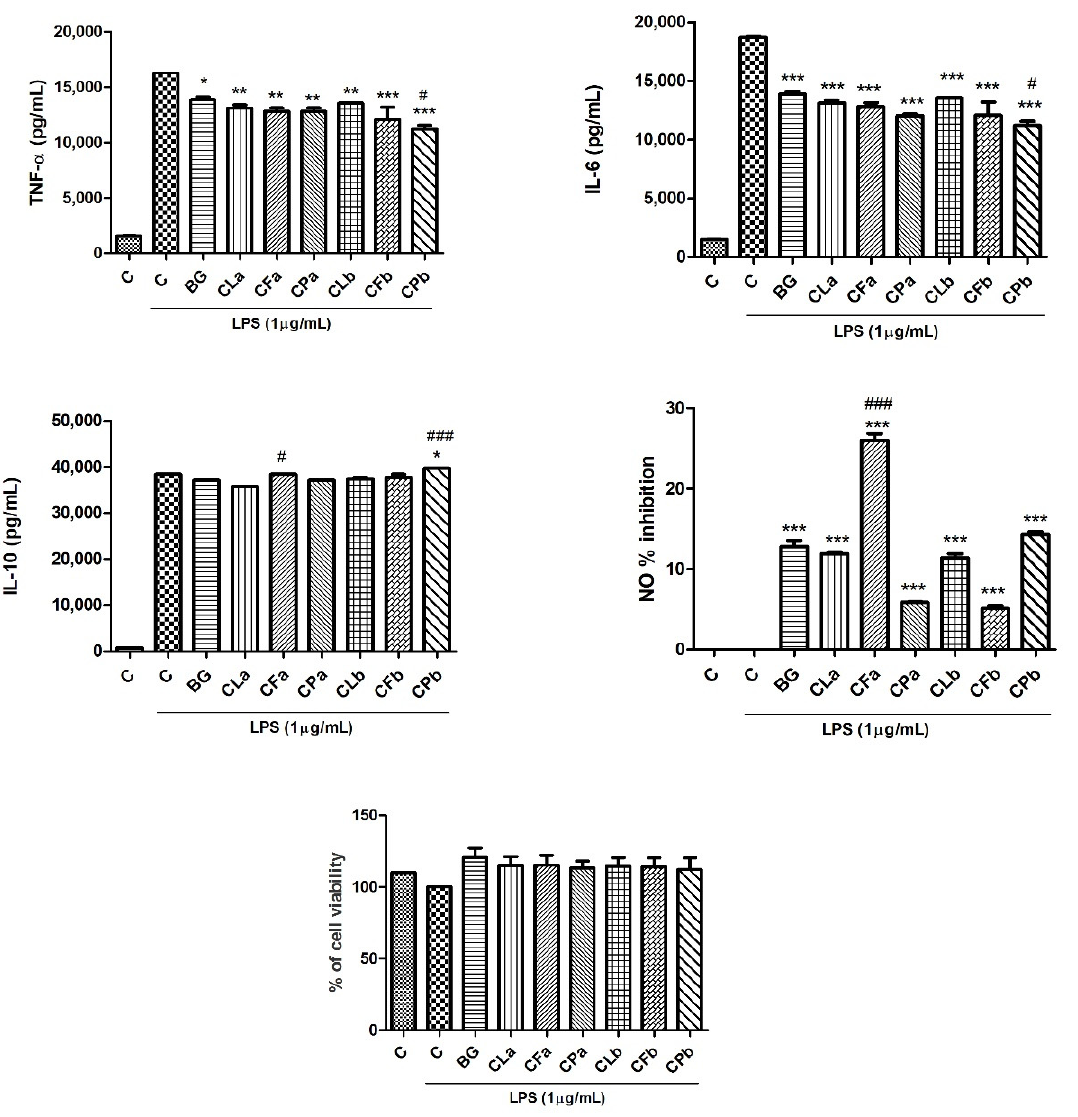
Figure 4. Bergapten (BG) was used as positive control. CL: C. libanotis ; CF: C. ferulacea ; CP: C. pungens . Formulations “a” and “b” were prepared as reported in the Materials and Methods Section 3.2. Significant difference versus control with LPS: * p < 0.05; ** p < 0.01; *** p < 0.001; significant difference versus bergapten (positive control): # p < 0.05; ### p < 0.001 (Dunnett’s multiple comparison test).